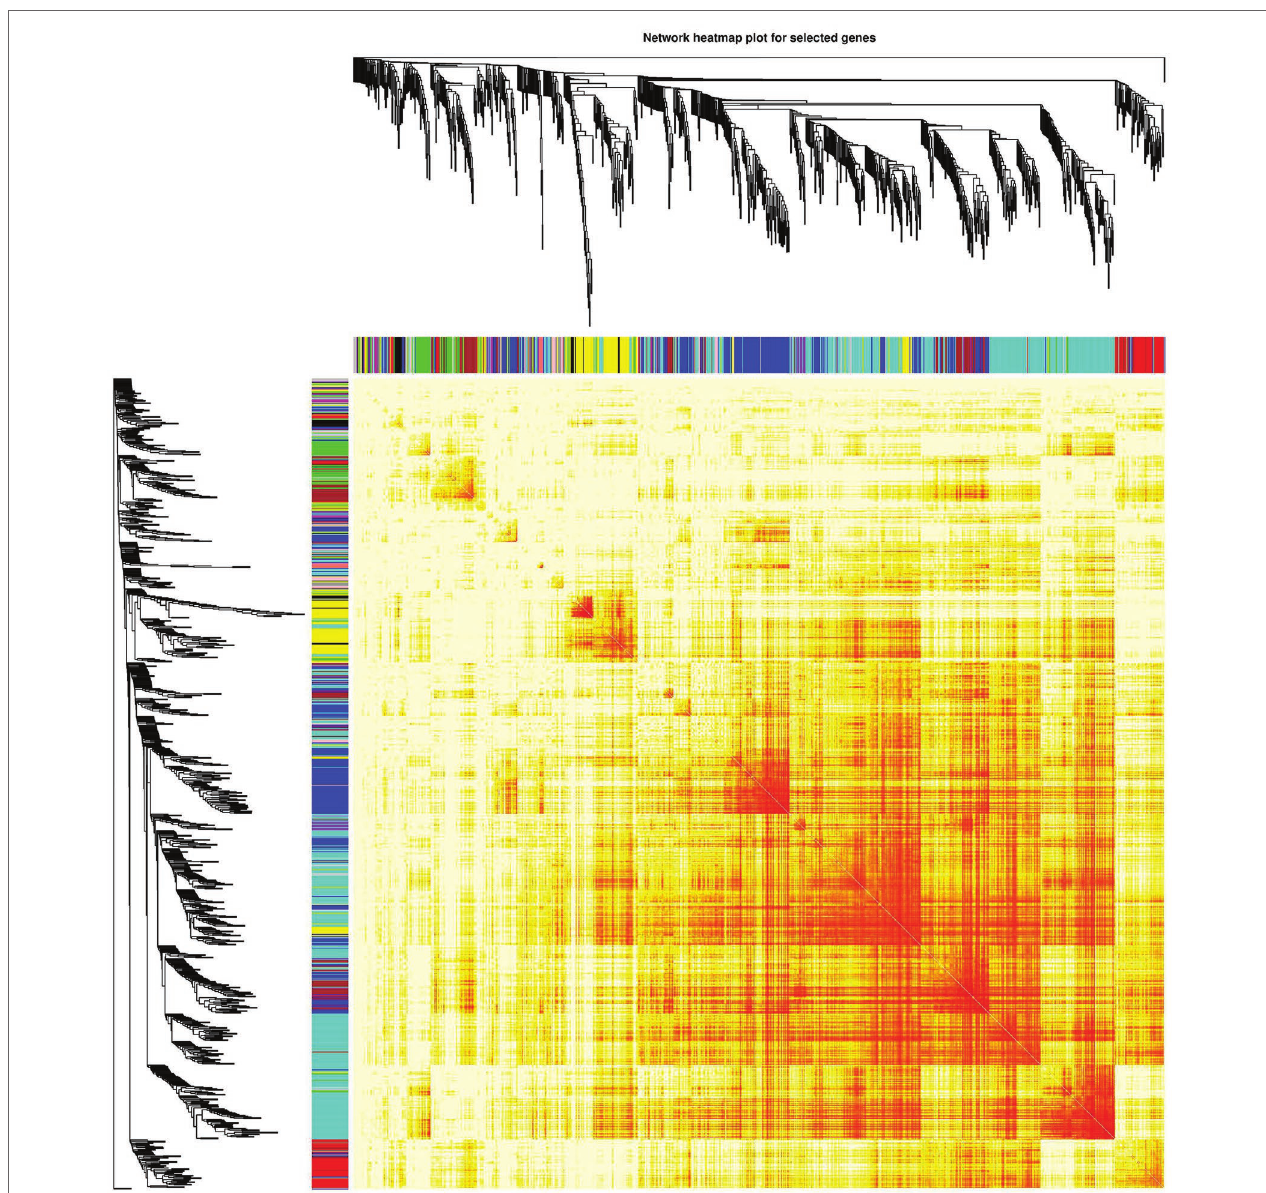
FIGURE 7 | Network heatmap of the gene modules. The tree represents a module (top and left), and the branch represents a gene. Darker the color of the dot (white → yellow → red), stronger the connectivity between the two genes corresponding to the row and column. Yellow tree represents “ME-FASN” module; Blue tree represents “ME-RPL” module; Turquoise tree represents “ME-SLC”